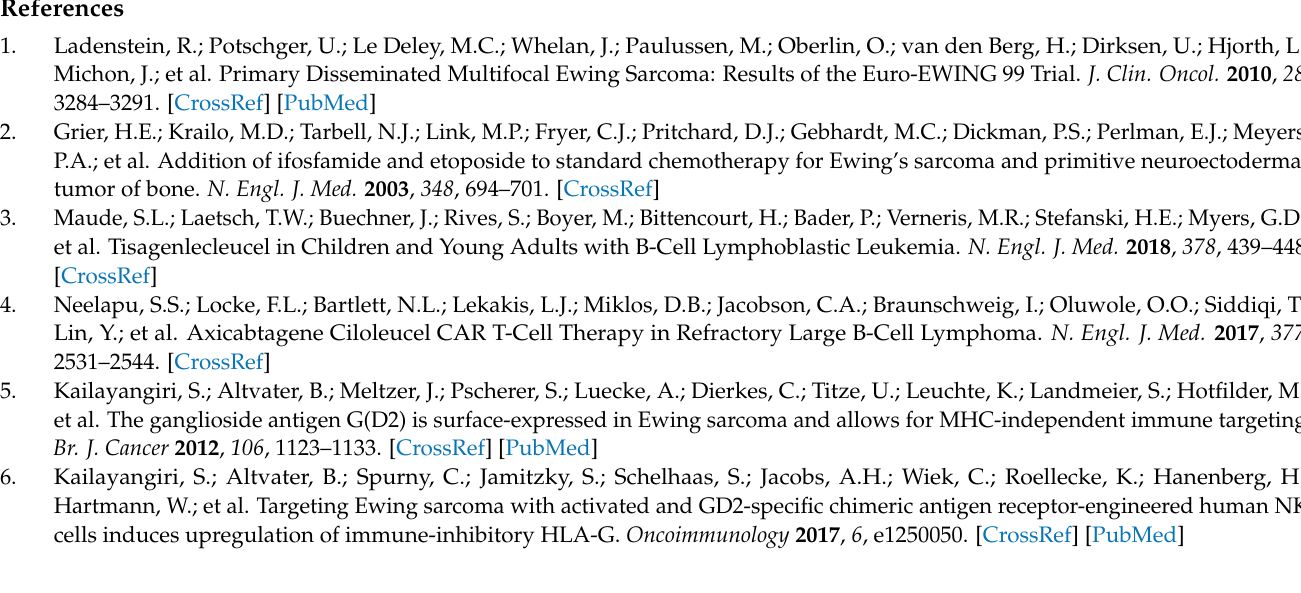
Figure A3. In vivo experiment used to provide tumor samples for HLA-E analysis. ( A ) Schematic of the in vivo experiment and timeline. ( B ) Percent (%) tumor volume. Murine blood, spleen, and EwS xenografts were obtained from previous mouse experiments approved by the animal care committee of the local government (LANUV, Recklinghausen, Az. 84-02.04.2014.A160). TC-71 cells had been injected subcutaneously into 8–12 week-old NOD scid gamma (NSG) mice. Upon a tumor volume of 50–100 mm 3 , 3 doses of 5 × 10 6 gene-modified, GD2.BB ζ T cells were injected intratumorally over a period of 2 weeks. Control mice received analogous injections of non-transduced T cells. Mice were sacrificed either earlier according to the score sheets or after a maximum of 28 days, post tumor injection. The analytic endpoint was relative tumor growth (in %), and was determined by dividing the tumor volume (mm 3 ) at the time of analysis by the initial tumor volume on day 1 (mm 3 ) ( × 100). For histological analysis, tumor tissue had been preserved. The experiment was not designed and performed for the direct purpose of the current research question. Outcome analysis of this in vivo experiment is not a subject of the current report.